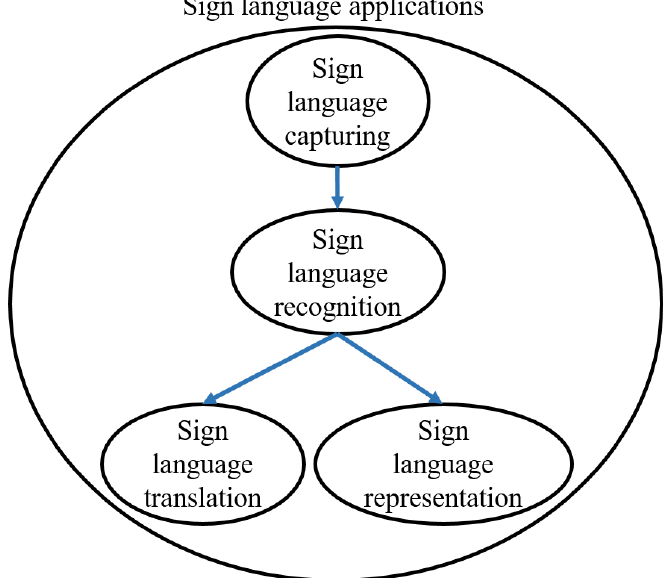
Figure 1. Sign language